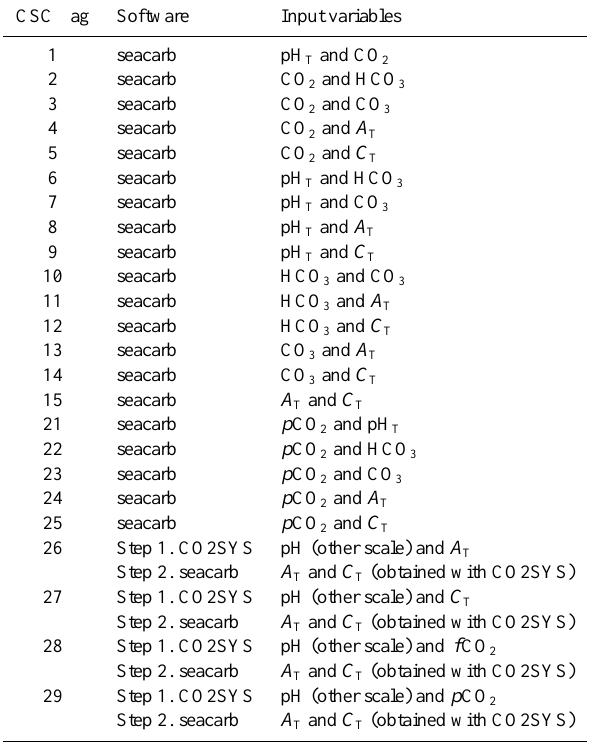
Table 1. Carbonate System Computation (CSC) flags describing which pair of variables (in addition to salinity and temperature) were used to compute the carbonate system variables listed in Ta- ble